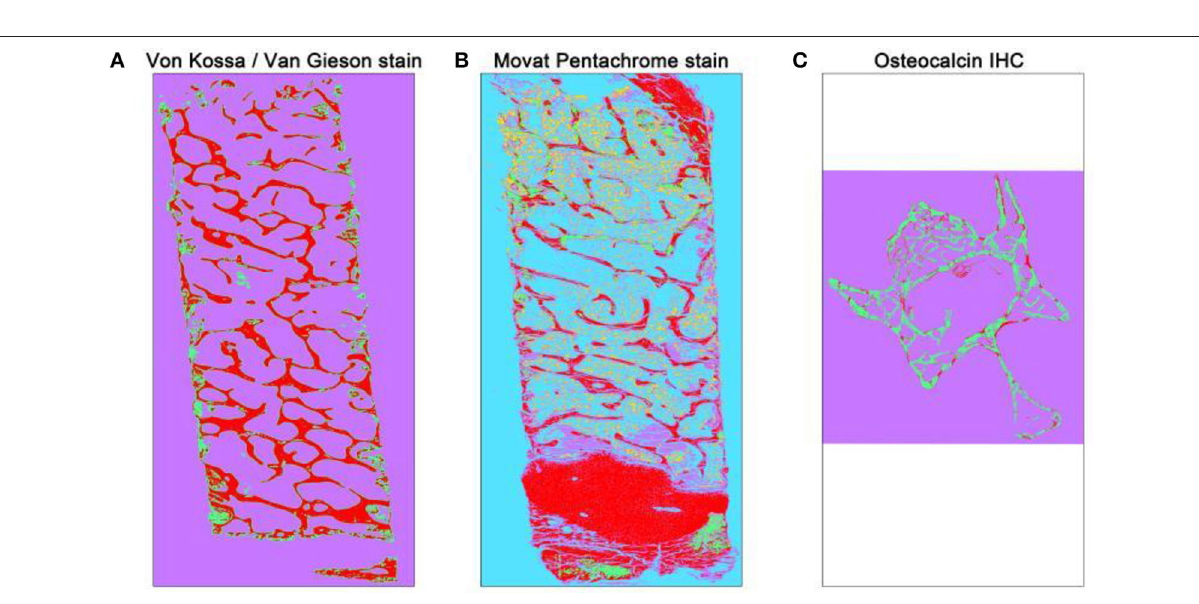
Frontiers in Endocrinology |